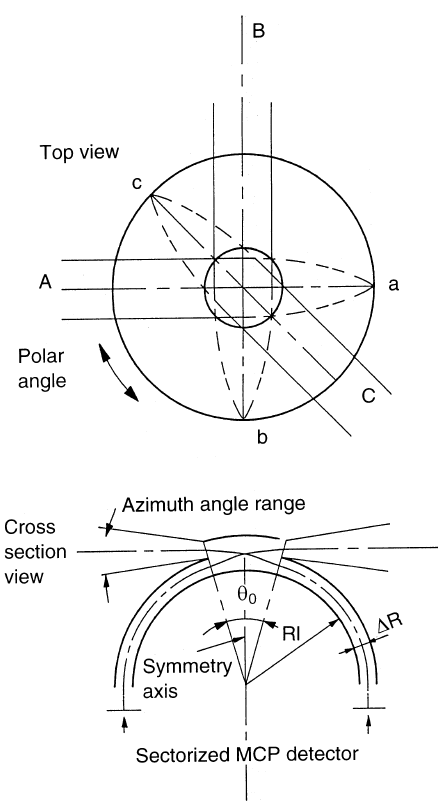
Fig. 1. Schematic views of the top-hat analyser and examples of parallel